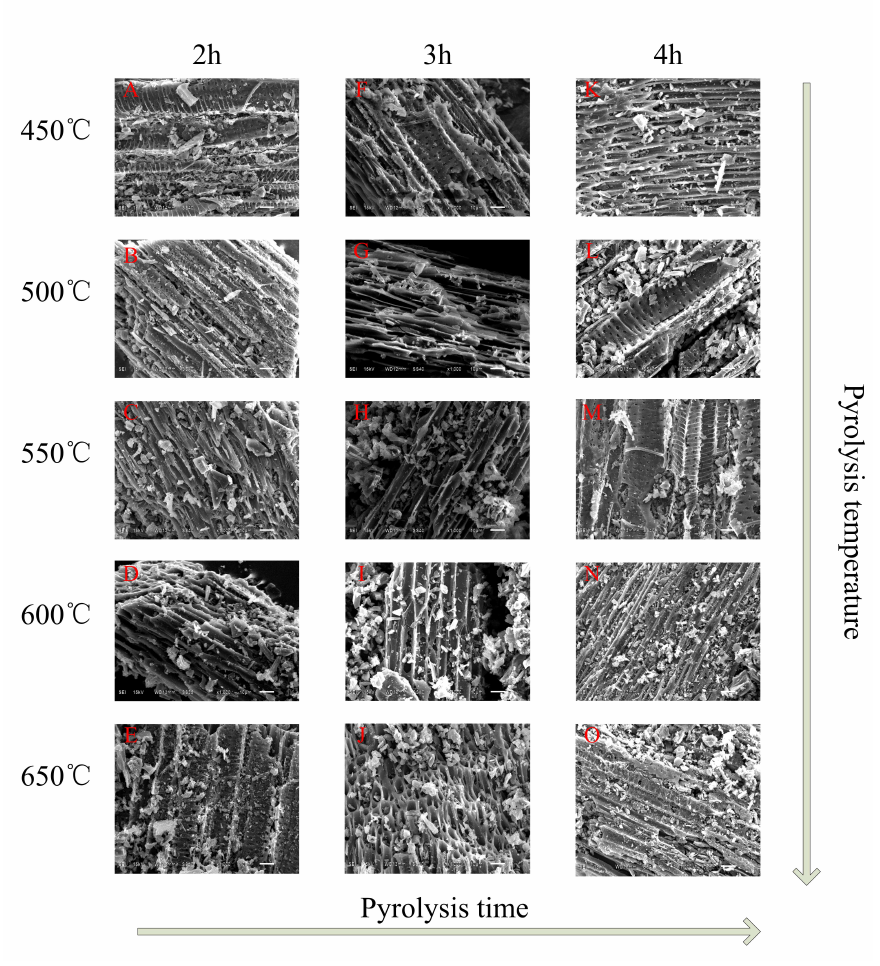
Figure 2. The scanning electron microscope (SEM) images of CB at 1000 times. ( A ) 450 ◦ C / 2 h, ( B ) 500 ◦ C / 2 h, ( C ) 550 ◦ C / 2 h, ( D ) 600 ◦ C / 2 h, ( E ) 650 ◦ C / 2 h, ( F ) 450 ◦ C / 3 h, ( G ) 500 ◦ C / 3 h, ( H ) 550 ◦ C / 3 h,